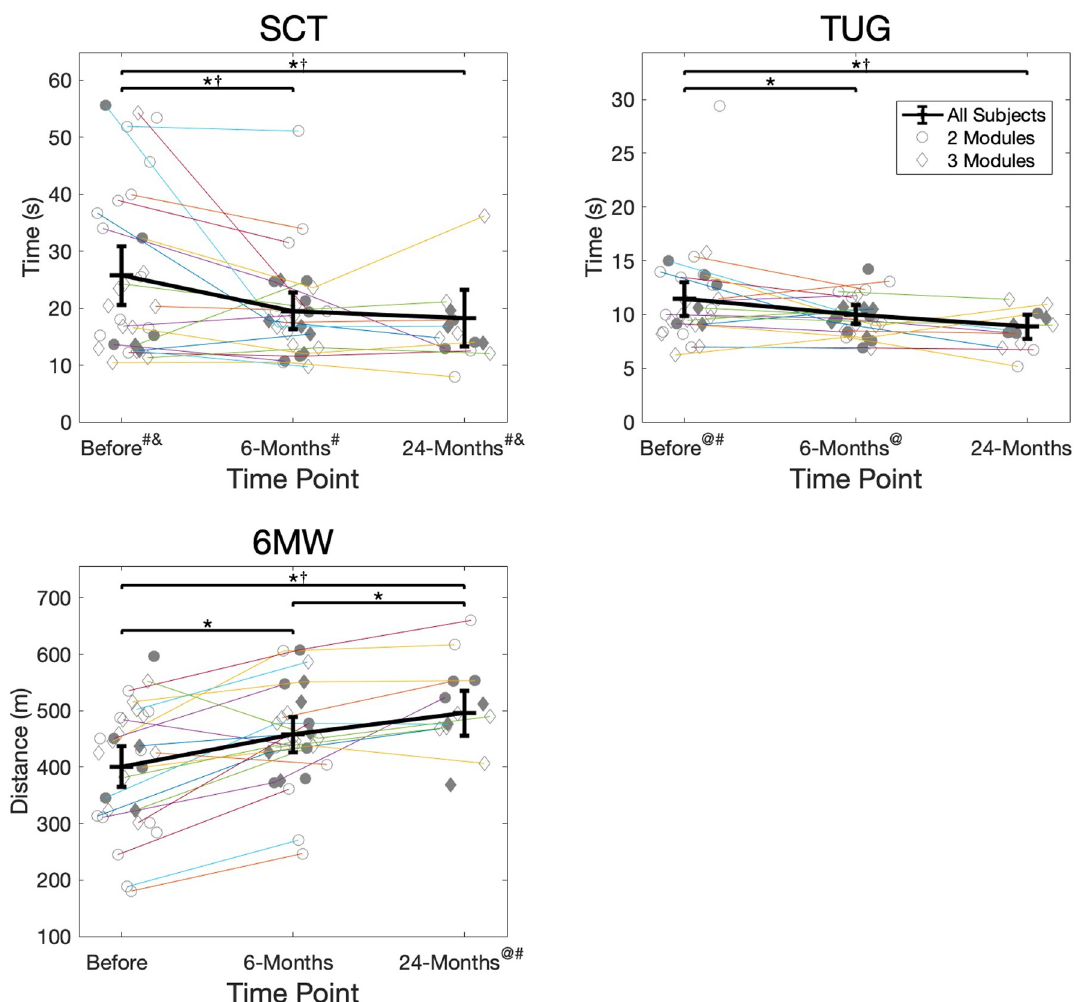
Fig 3. Performance-based function. Performance-based functional scores (SCT, TUG, 6MW) for each participant at each time point. Participants who were present for consecutive testing time points are connected. Filled symbols indicate participants with proper module organization. Thick black lines indicate the group estimated means and 95% confidence intervals at each time point, determined by the GLMM. � /† = statistically significant ( � ) and clinically meaningful (†) differences in function between time points. @/# = statistically significant (@) and clinically meaningful (#) differences in function between groups demonstrating the same number of modules at each time point. & = clinically meaningful differences in function between groups demonstrating proper or poor module organization at each time point. There were no statistically significant